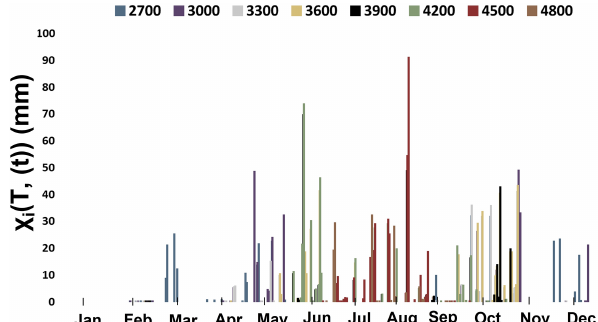
Figure 11. The variation of annual PDD values estimated based on monthly mean temperatures at different elevations in the MBM from 1952 to 2019.